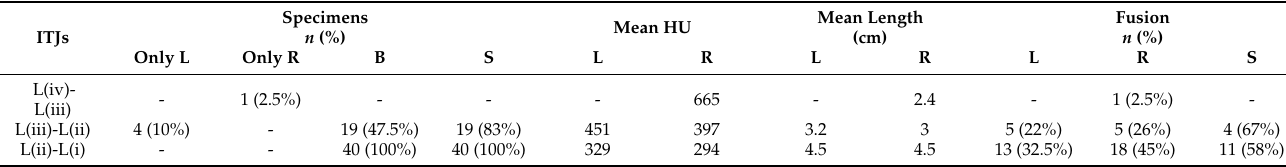
(L(iii)-L(ii): r = − 0.81; L(ii)-L(i): r = − 0.81) and right side (L(iii)-L(ii): r = − 0.71; L(ii)-L(i): r = − 0.76). There was a correlation between both the left and right lengths ( r = 0.6) of the